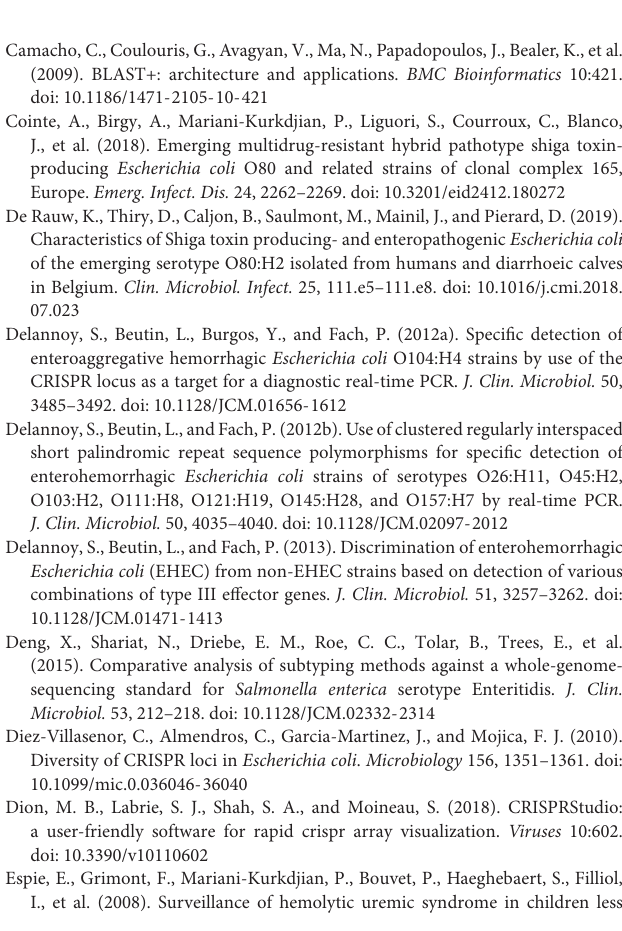
FIGURE S1 | The distribution of stx2d gene (A) and HUS cases (B) among four CRISPR lineages. Significant difference ( p value < 0.05) are indicated by an asterisk (ns, no